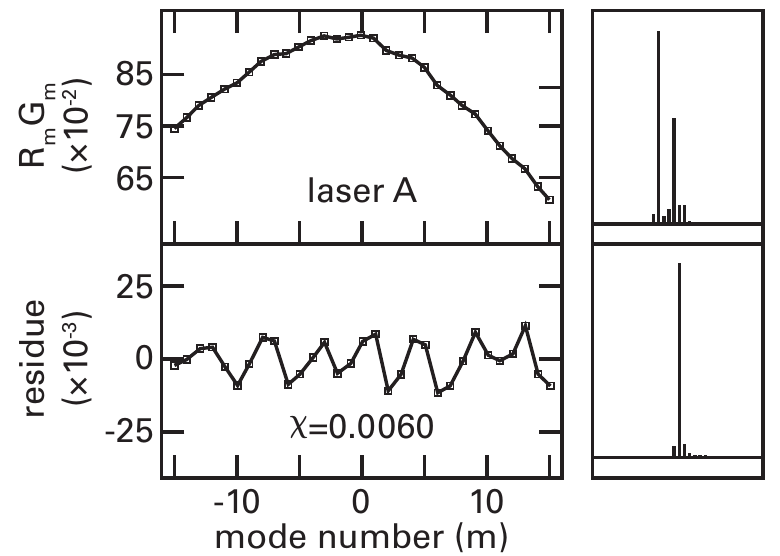
Figure 11. RG product, residue, and worst case above-threshold spectral outputs for a device with a strongly modulated spectral envelope. Adapted with permission from Figure 3 of [37] ©The Optical